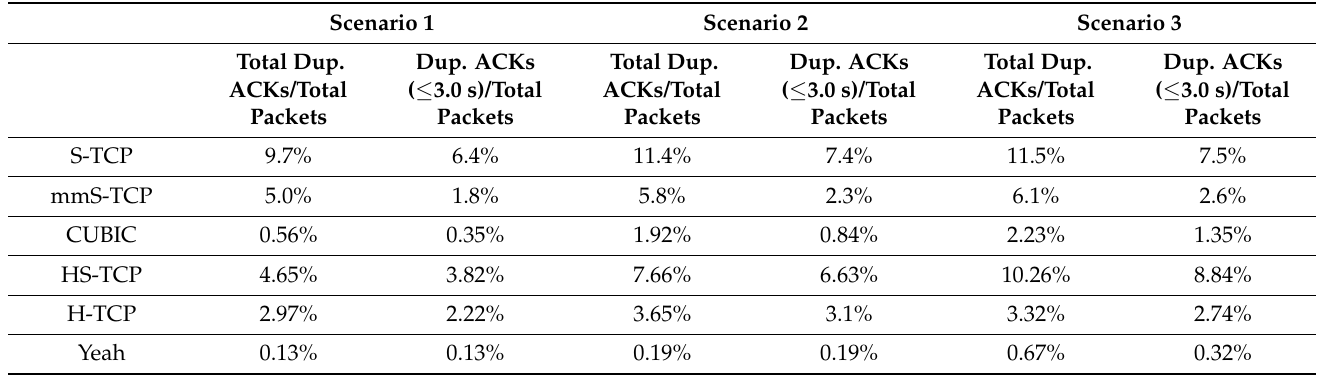
Table 2. Comparisons of the rate of duplicated ACKs to total packet.